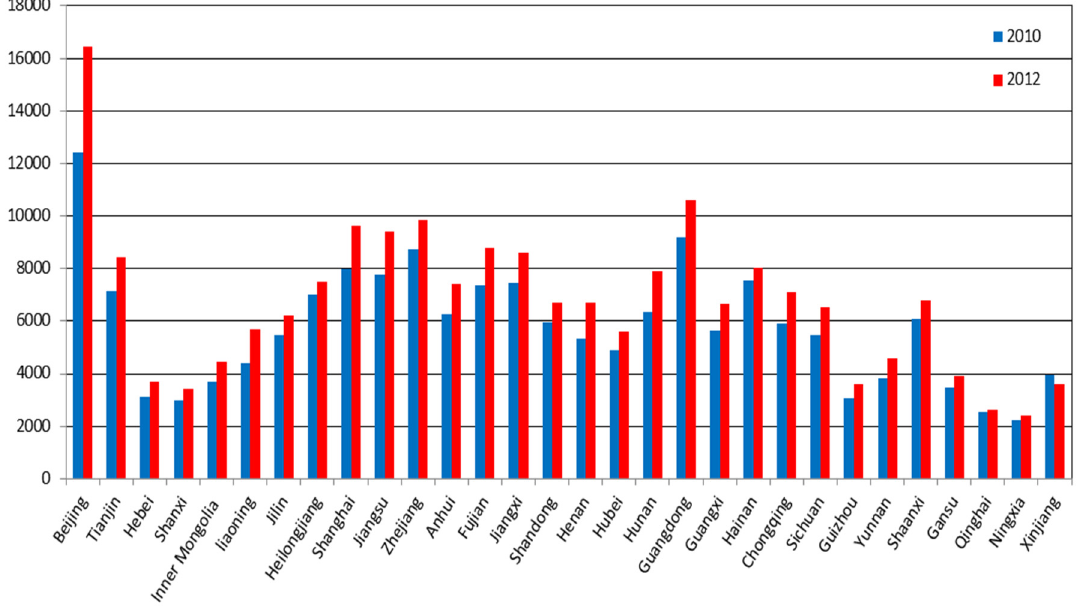
Figure 1. Actual productivity distribution of different provinces in 2010 and 2012.